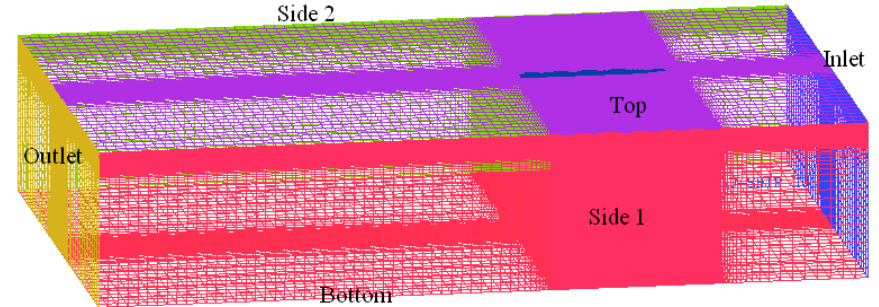
Figure 1. Boundary conditions calculation domain.